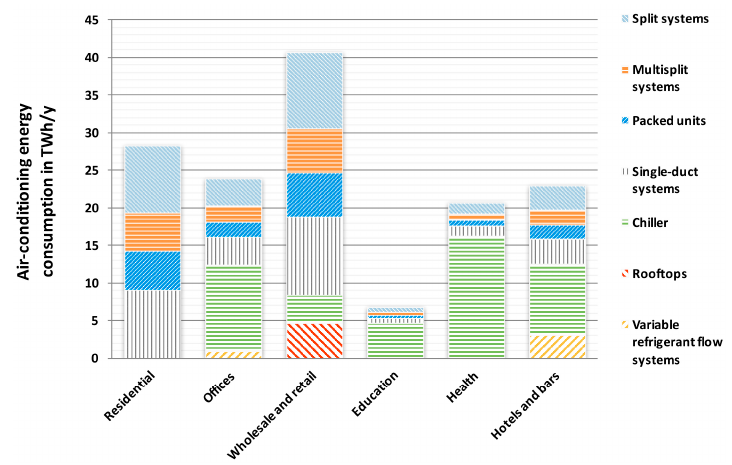
Figure 2. AC energy consumption per type and sector, EU28 (see references in the Appendix A,